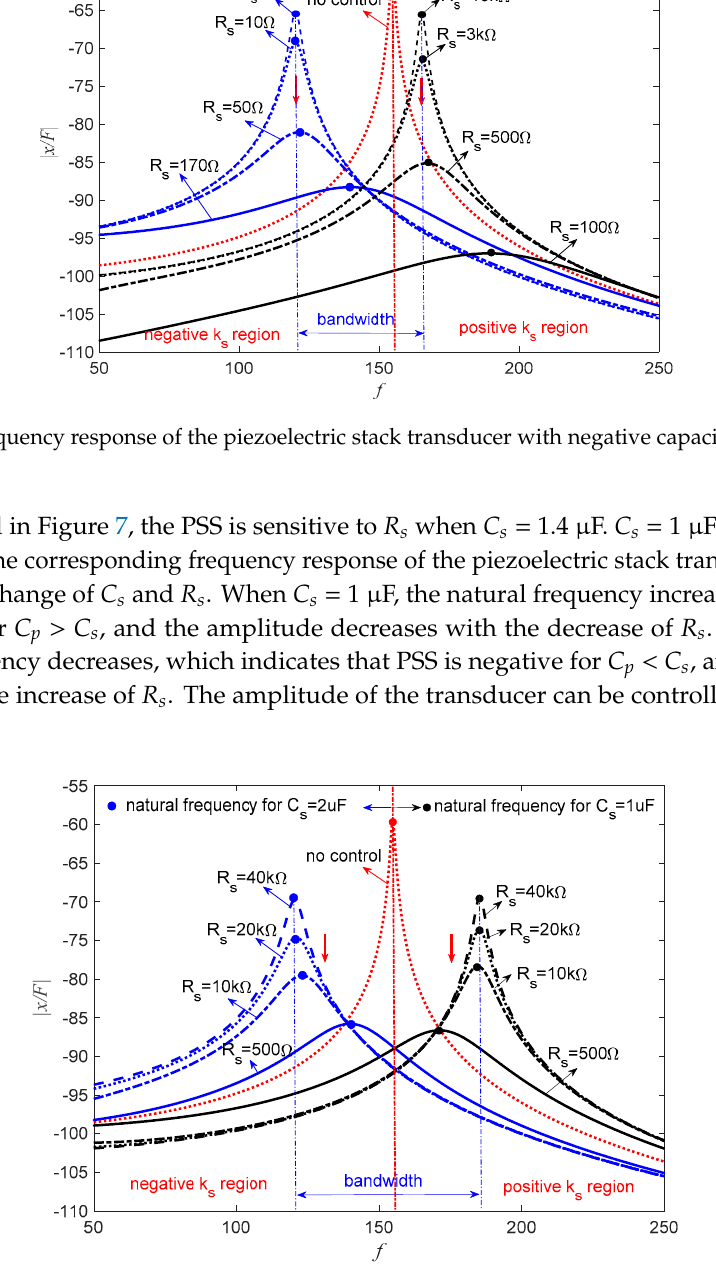
Figure 16. Frequency response of the piezoelectric stack transducer with negative capacitance in parallel with R s .